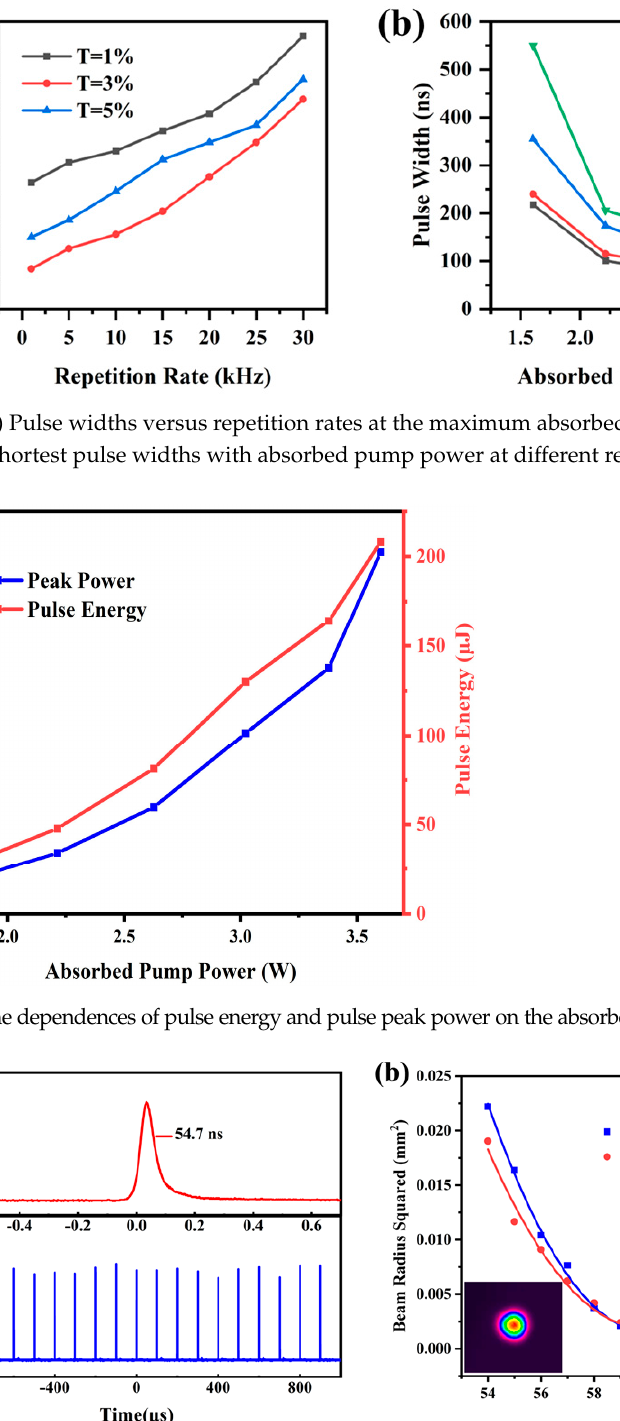
Figure 5. ( a ) Pulse widths versus repetition rates at the maximum absorbed pump power; ( b ) Vari- ation of the shortest pulse widths with absorbed pump power at different repetition rates.